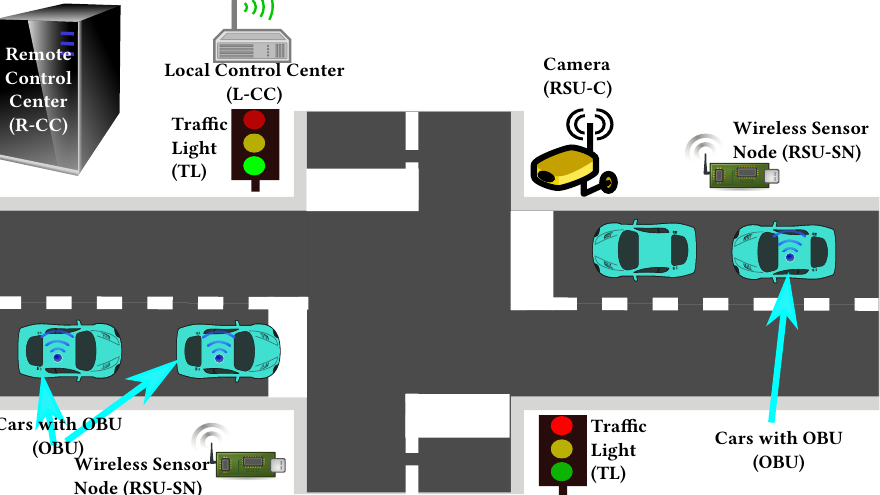
Figure 5. Typical scenario for a V2I cooperation system for traffic